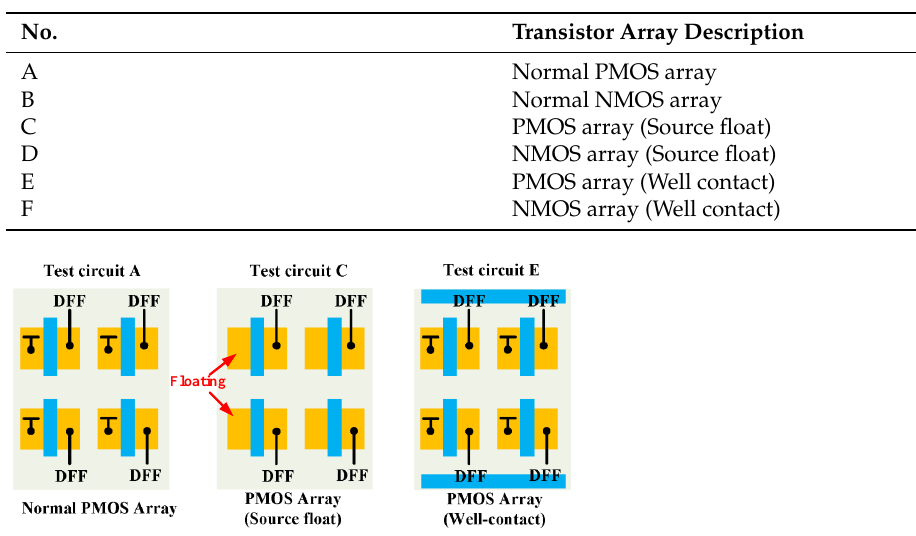
Table 1. Transistor array types in the test chip.